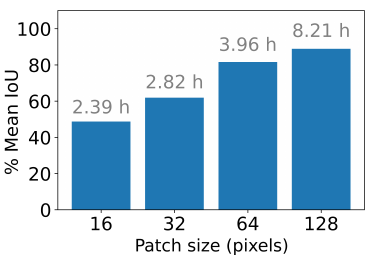
Figure 9: Mean IoU values obtained with different input patch sizes. The total time taken to complete training and testing is also indicated, in hours (h). The results are for all three lakes combined, training on 2016 - 17 and testing on 2017 - 18